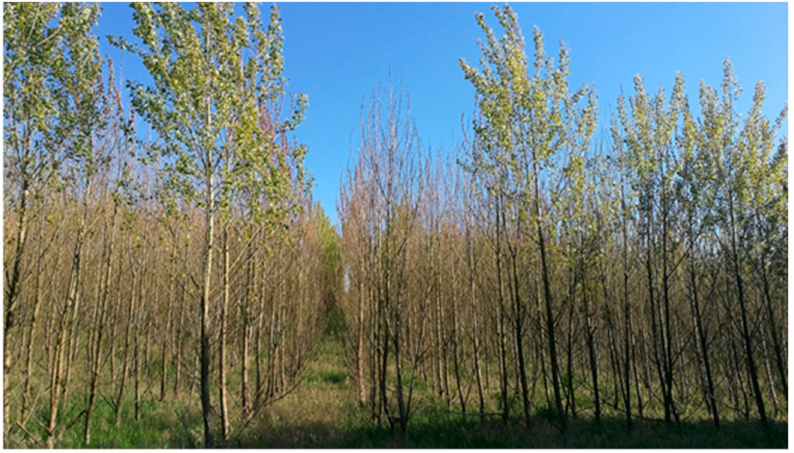
Figure 1. Poplar plantation with diseased